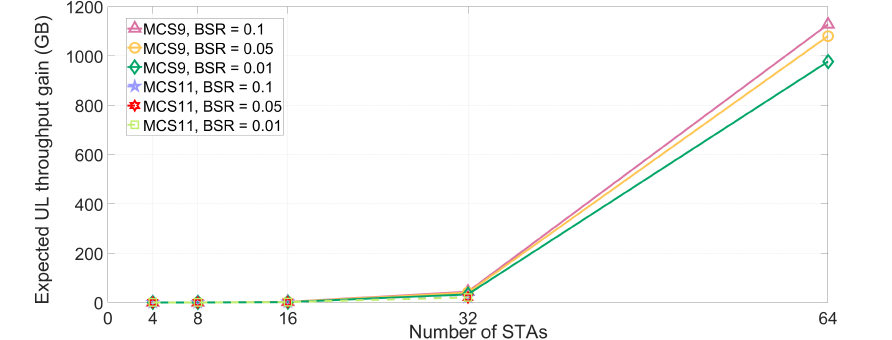
Figure 10. Expected throughput gain for UL transmission.